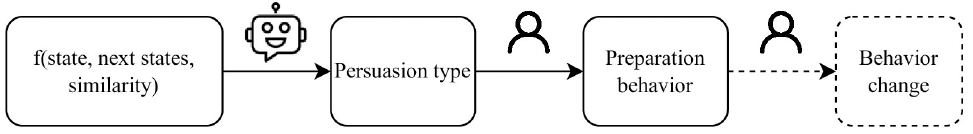
Fig 1. Overarching goal of our work. The goal of our persuasion algorithm is that people do their preparatory activities more thoroughly, which is supposed to facilitate quitting